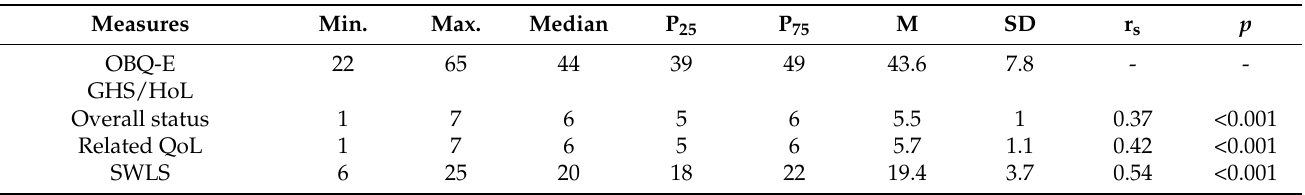
Table 3. Score distribution for the total OBQ-E, GHS/QoL (overall status and related QoL), and SWLS, and conver- gent